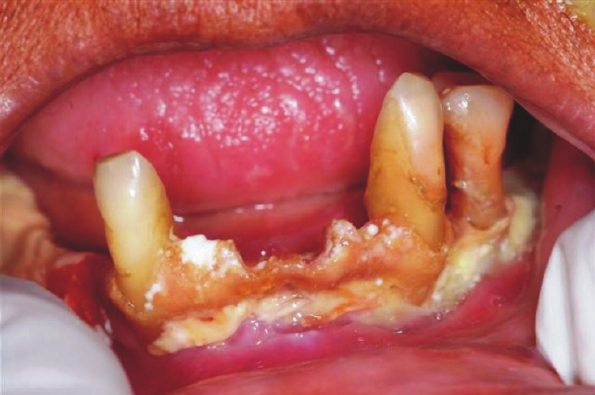
Figure 7 - Oral ulceration, bone exposure and tooth mobility/loss in cancrum